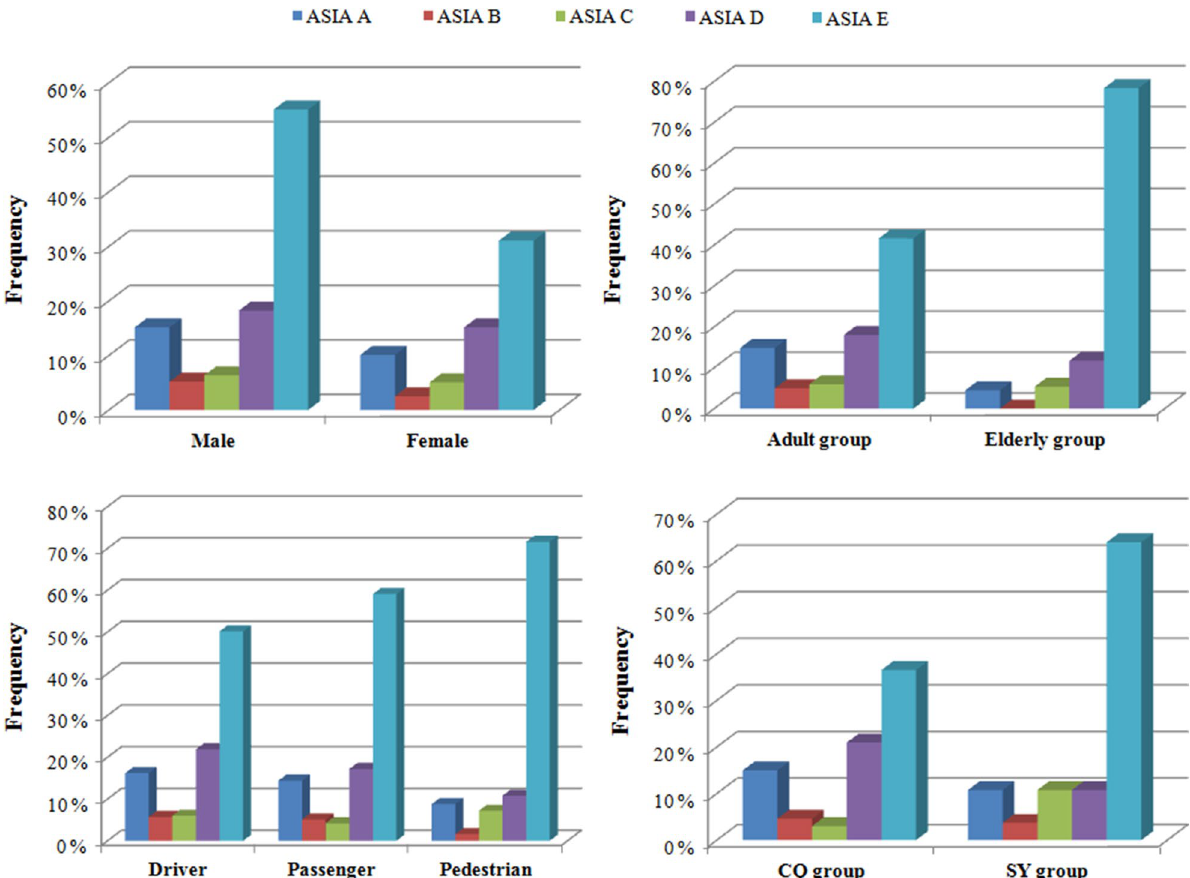
Figure 4. Distributions of spinal cord injury (ASIA classification) according to different